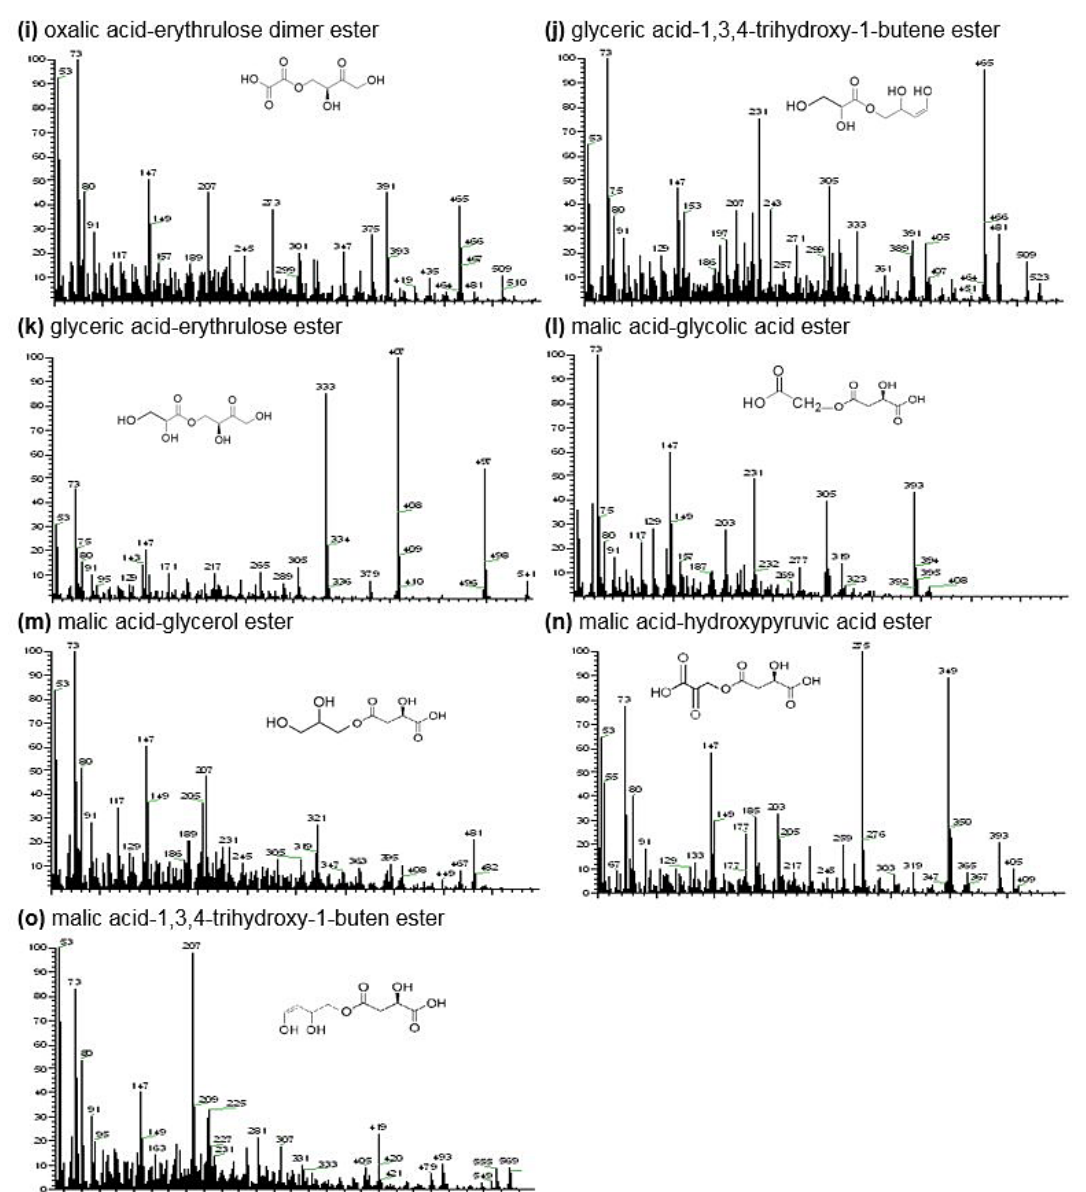
Figure 3. CI mass spectra of oligoester compounds present in irradiated 1,3-butadiene/NO x